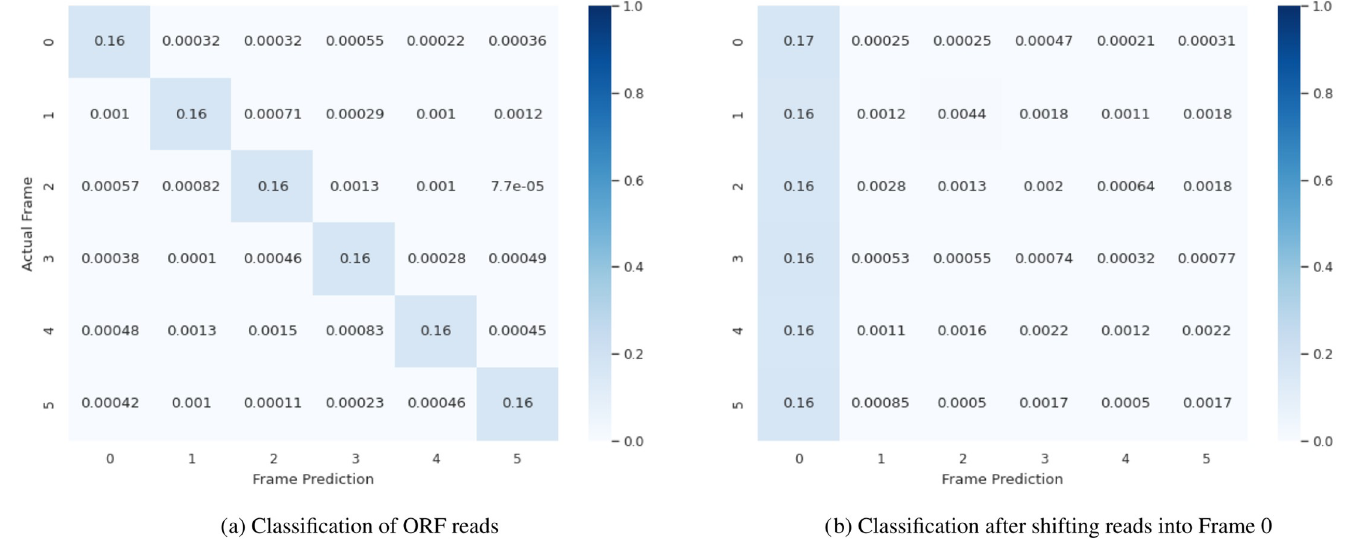
Fig 2. Prediction results of the frame classification model on the test dataset. Predictions of the most probable class ^ k on the frame test data [41] are shown as an error matrix. The classes are as follows: on-frame (0), offset by one base (1), offset by two bases (2), reverse-complementary (3), reverse-complementary and offset by one base (4), reverse complementary and offset by two bases (5). (A) represents the initial classification results of the reads. (B) Re-evaluation of the reads after applying the frame correction to validate that the reads were correctly shifted to be on-frame, i.e., k = 0.